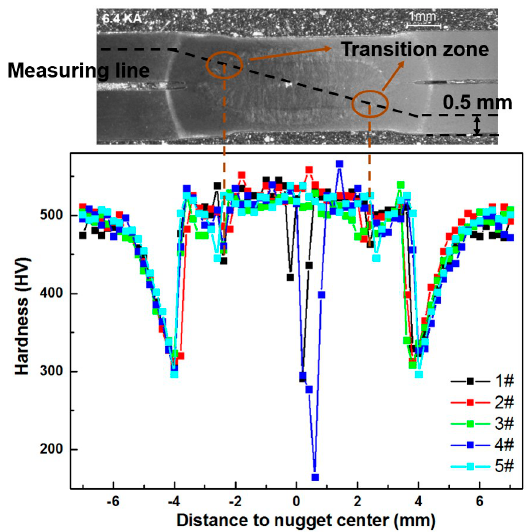
Figure 12. Microhardness fluctuation at the cross-section of the overall joint.